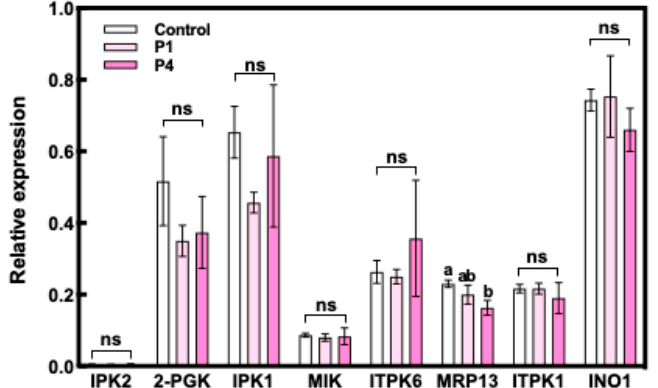
Figure 5. Expression level of PA biosynthesis genes in Nipponbare. White, pale pink, and pink indicate the control, P1 treatment, and P4 treatment, respectively. Each value represents the mean ± SD of three replicates. Different letters indicate statistical differences (Tukey’s HSD test, p < 0.05).